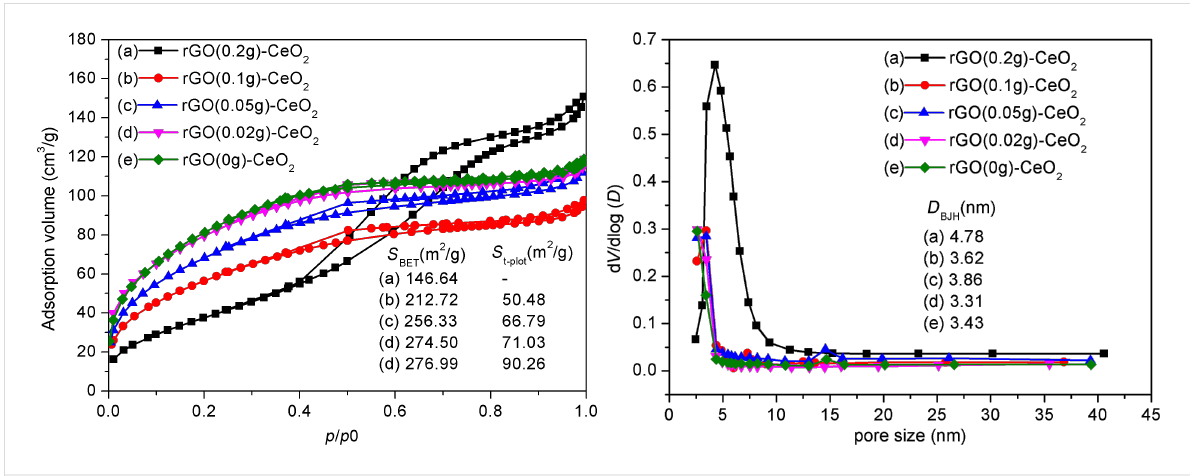
Figure 5: N 2 adsorption–desorption isotherms (left) and pore size distributions (right) for CeO 2 with rGO-like organic residues (rGO(0)–CeO 2 ) (e) and rGO–CeO 2 composites (a–d) with different proportions of rGO after solvothermal treatment with ethanol.